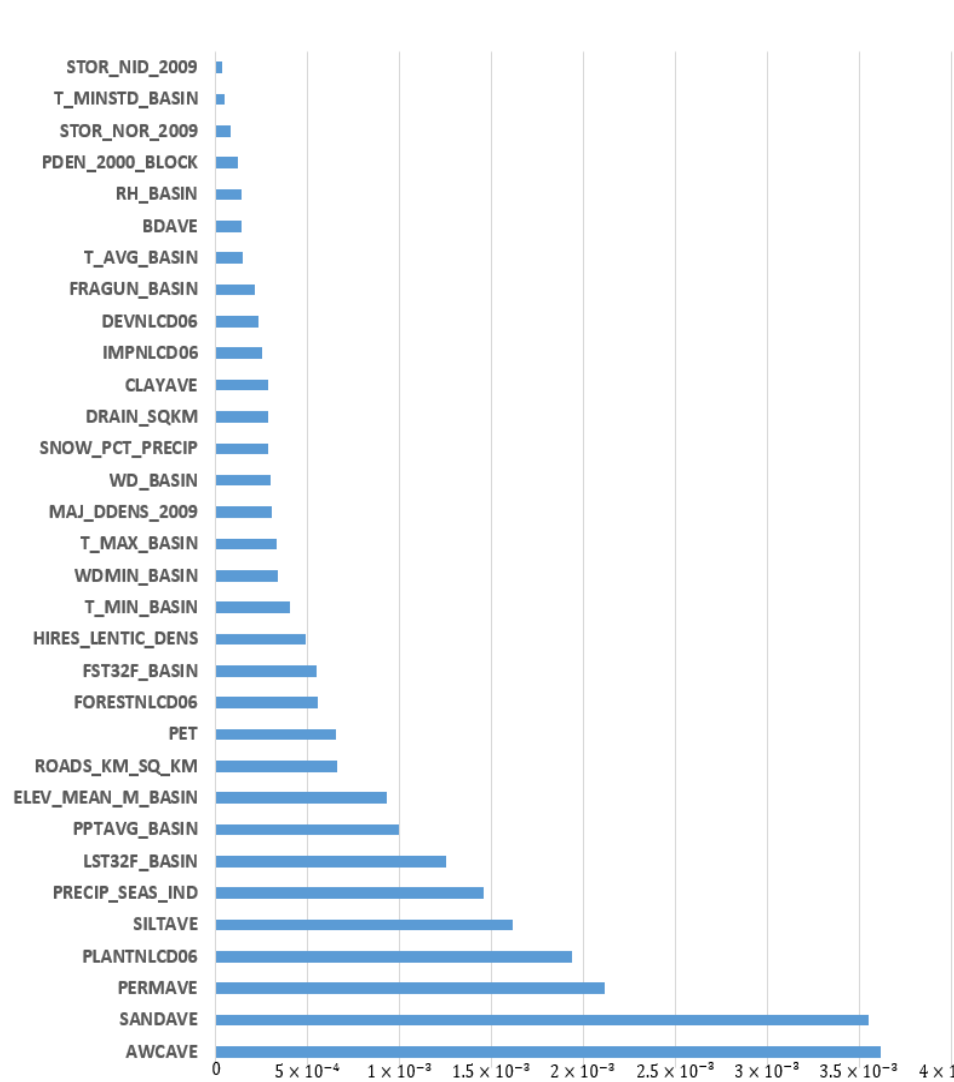
Figure 7. Predictor variables of the shape parameters (with associated importance) for Coastal Plain. Description of predictor variables is provided in Appendix A.